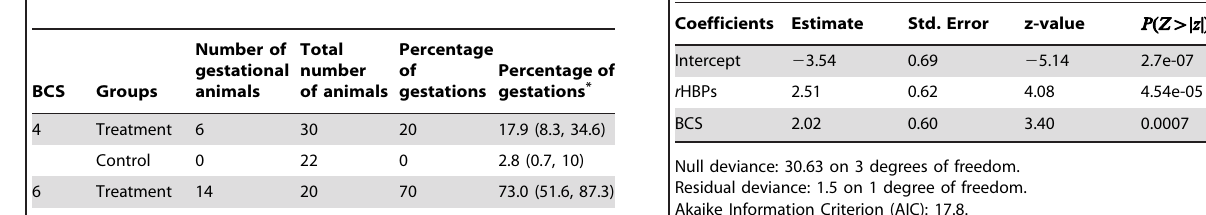
Table 1. Comparison of body condition scores (BCS) and the number of gestational females in each experimental group which consisted of crossbred heifers inseminated with cryopreserved sperm with (treatment) or without (control) recombinant heparin binding proteins.